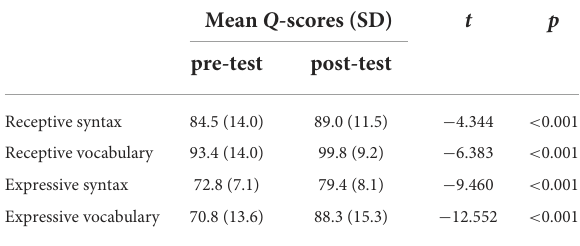
TABLE 1 The mean pre-test and post-test language scores of all 183 children, compared with t -tests.